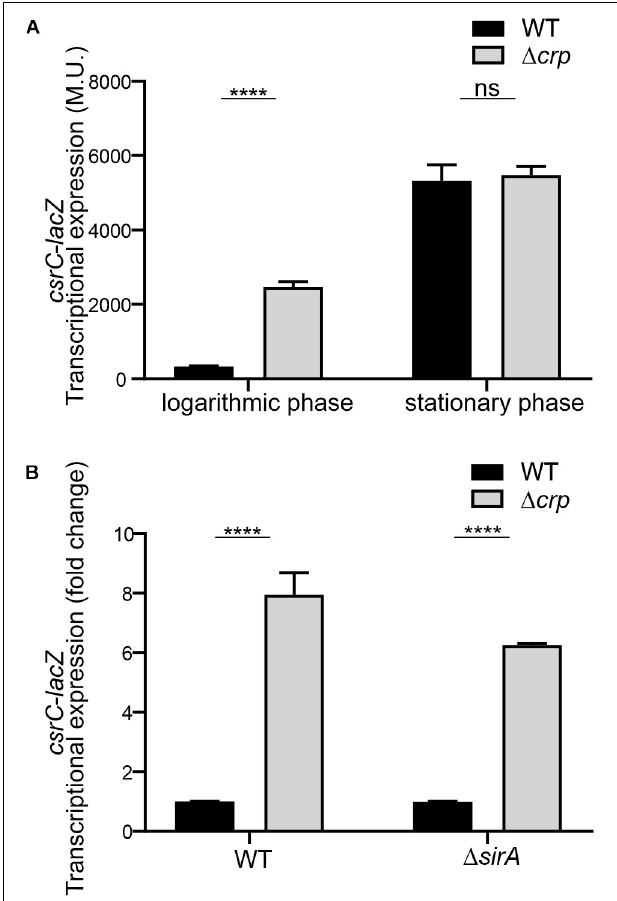
FIGURE 2 | CRP-cAMP mediated repression of csrC is independent of SirA. (A) Transcriptional expression of chromosomal csrC - lacZ fusion was monitored in WT and (cid:49) crp mutant genetic backgrounds. Cultures were grown in LB at 37 ◦ C up to an OD 600 nm of either 0.4 or 2.0. (B) Transcriptional expression of the chromosomal csrC-lacZ fusion was monitored in WT, (cid:49) crp , (cid:49) sirA, and (cid:49) crp (cid:49) sirA genetic backgrounds. The transcriptional expression is shown in relative values. In each case, the reference ( crp + , WT) was set as 1.0. Miller units of the crp + backgrounds were 308 ± 19 and 28 ± 0.8 for WT and (cid:49) sirA, respectively. β -galactosidase activity was determined for three independent cultures, average and standard deviation is presented. **** p < 0.0001; ns, not